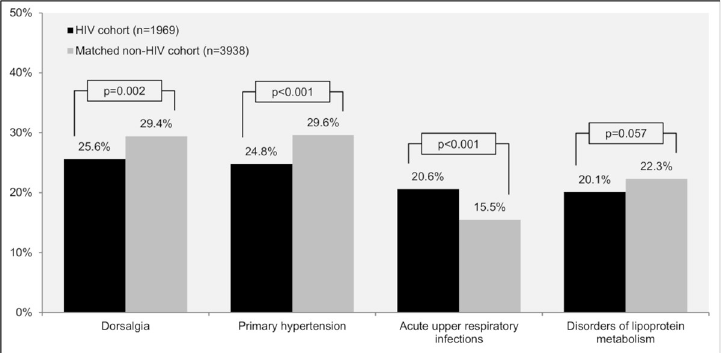
Fig 2. Prevalence of the 4 most common comorbidities in PLHIV and a matched non-HIV cohort over the previous 12